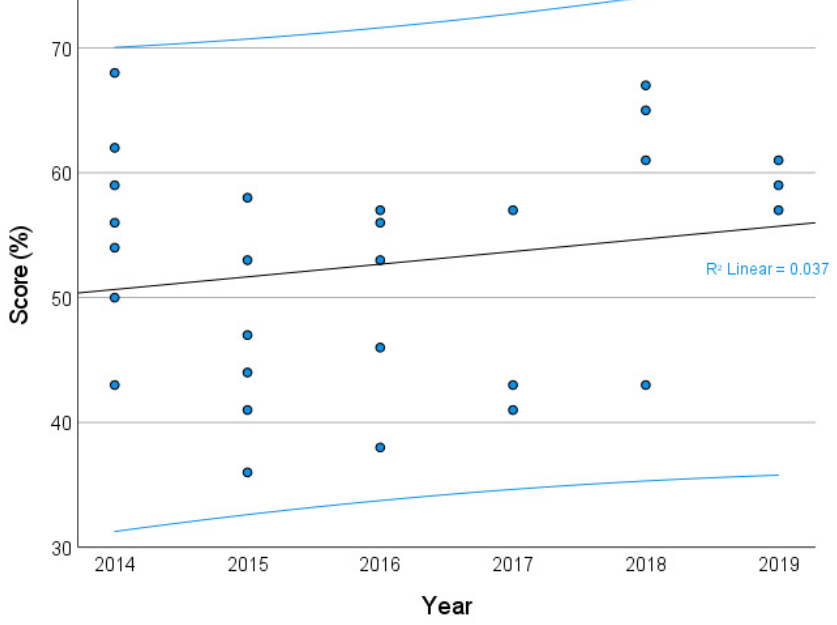
Figure 4. Trend in the score from 2014 to 2020. The trendline presented is from the Mann–Kendall trend analysis on the median of the scores. The stapled lines indicate the 95% confidence interval. The scores for each of the checklist items are shown in Figure 5. The data were